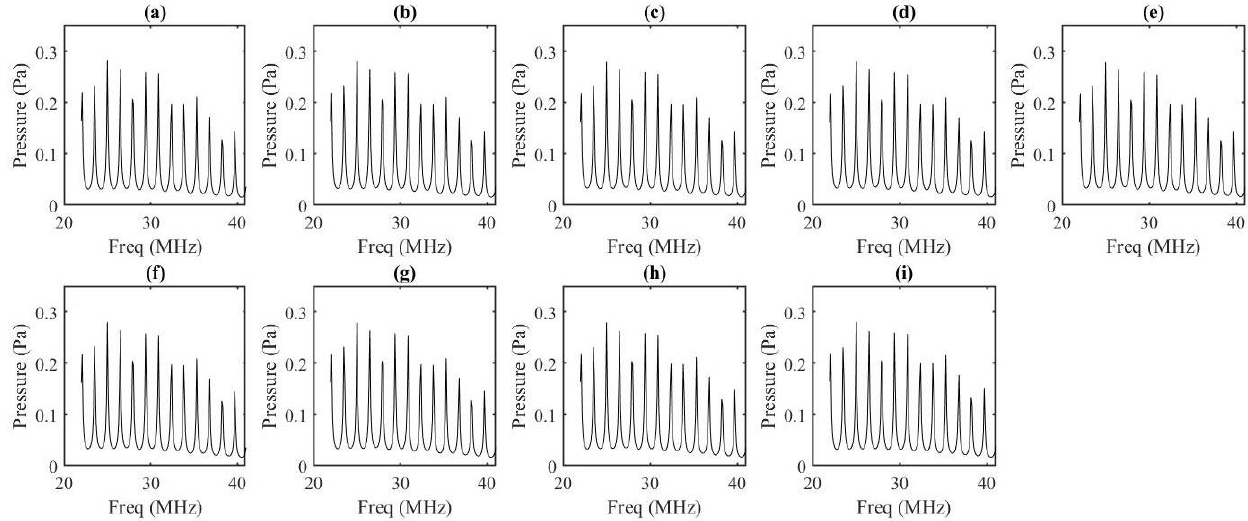
Figure 9. Frequency spectrum in Sector 2 for flake positioned at ( a ) − 2 mm, ( b ) − 1.5 mm, ( c ) − 1 mm, ( d ) − 0.5 mm, ( e ) 0 mm, ( f ) 0.5 mm, ( g ) 1 mm, ( h ) 1.5 mm, and ( i ) 2 mm.